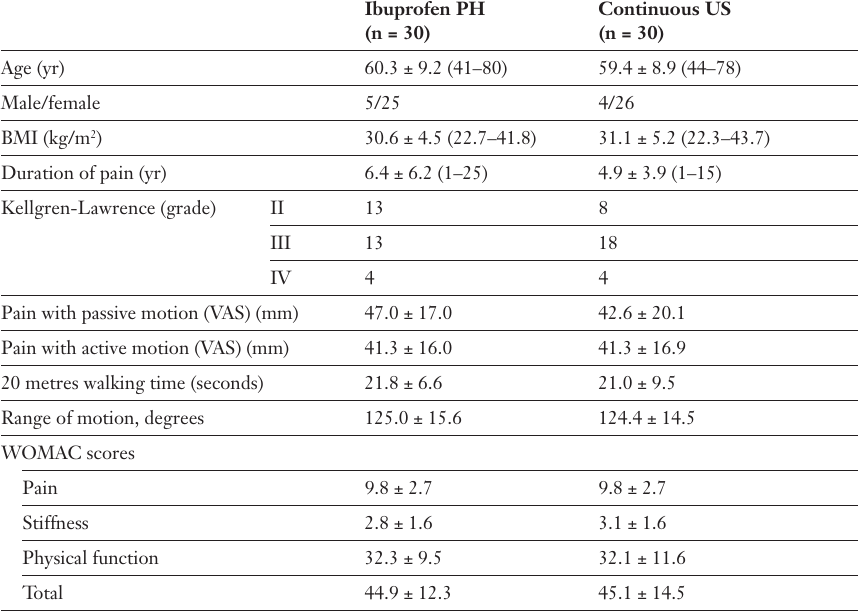
Baseline characteris- tics of patients with osteoarthritis of the knee assigned to receive ibuprofen phonophoresis or continuous ultra- sound.